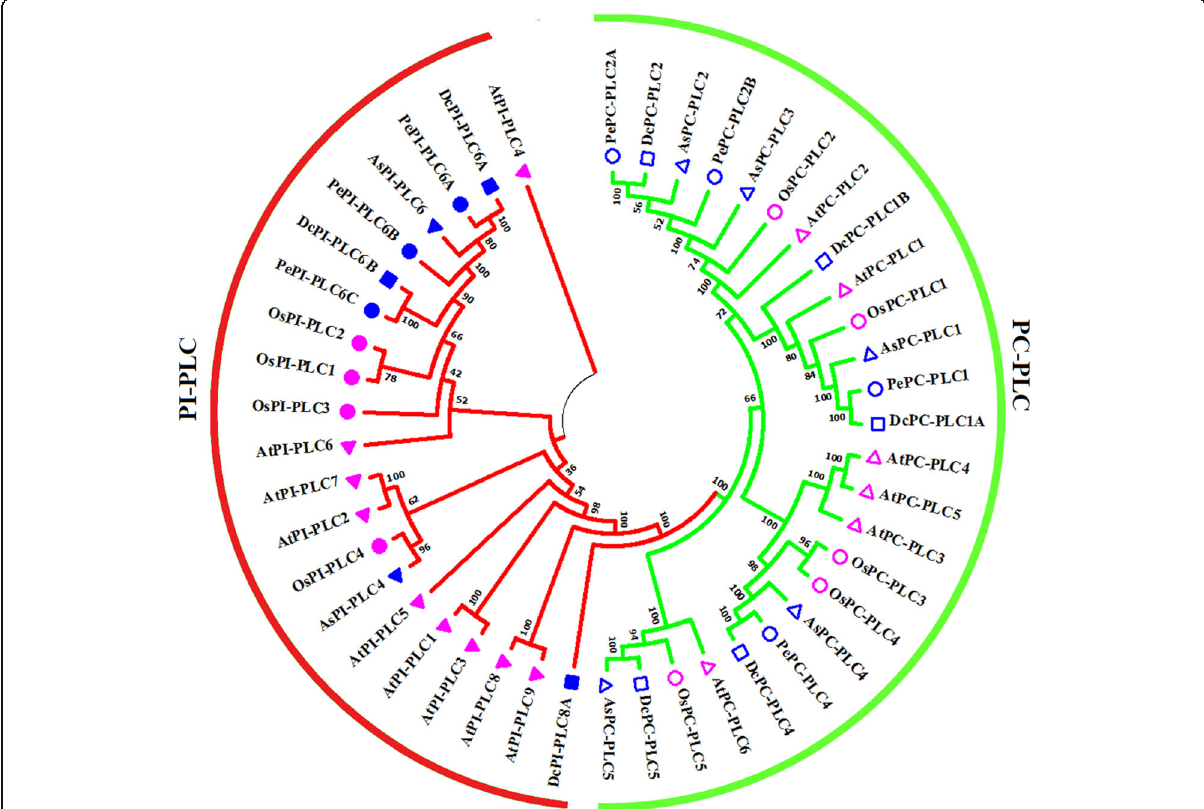
Fig. 4 Phylogenetic analysis of PePLC, DcPLC and AsPLC proteins. Phylogenetic clustering of PePLC, DcPLC, and AsPLC protein sequences was done with AtPLC, and OsPLC sequences. The PI-PLC and PC-PLC groups are marked respectively in red and